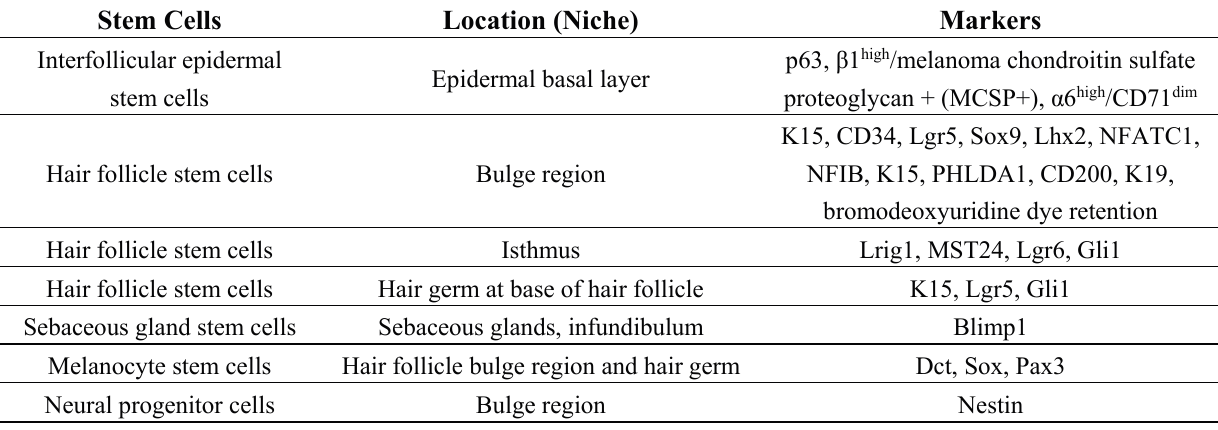
Table 1. Some examples of epidermal and hair follicle stem cells and their locations and